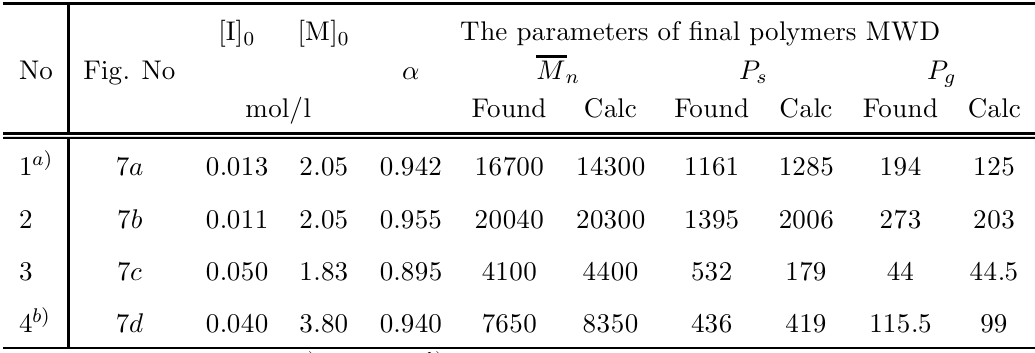
Table 1 Comparison of some calculated and measured characteristics of polybutadienes obtained by polymerization of butadiene under the action of 1,4-dilithium pentane in heptane at